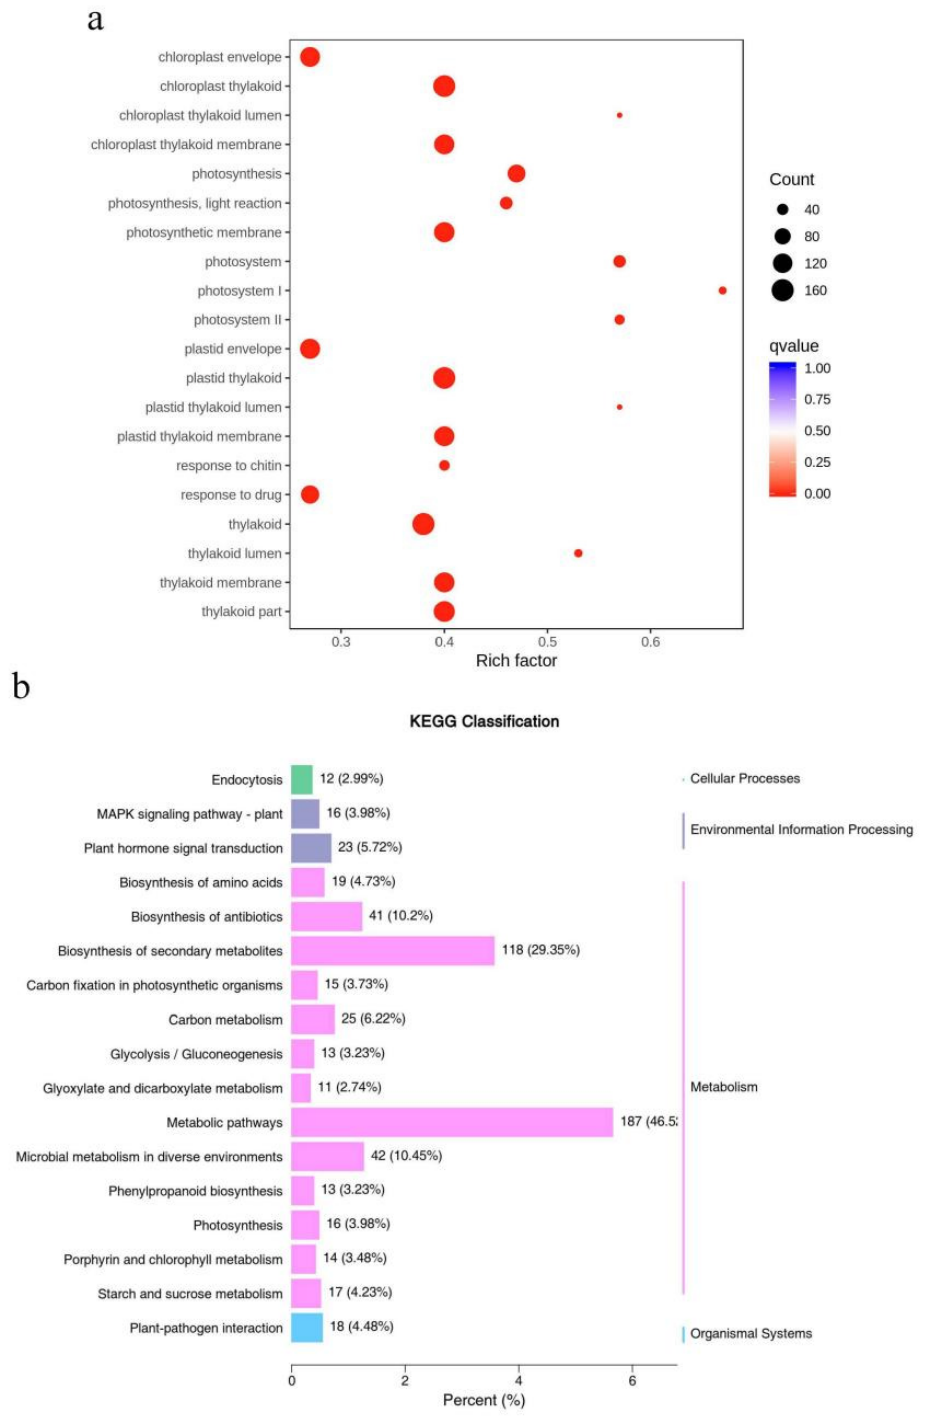
Figure 4. Functional classification of DEGs between pericarp of B214 and B227 mature fruit: ( a ) Enriched GO items. X -axis represents rich factor, which is the ratio between number of DEGs and number of genes assigned to the GO item. A big rich factor indicated a high enrichment level. Color of bubbles represents the p value, the redder, the more significant. Size of bubbles represents the number of DEGs in the item, the larger, the more quantities. Y -axis represents GO terms. ( b ) Histogram showing enriched KEGG pathways. X -axis represents the percentage of annotated genes in the pathway among all annotated genes. Y -axis represents the names of KEGG pathways. Categories of KEGG pathways were listed at the right side of the